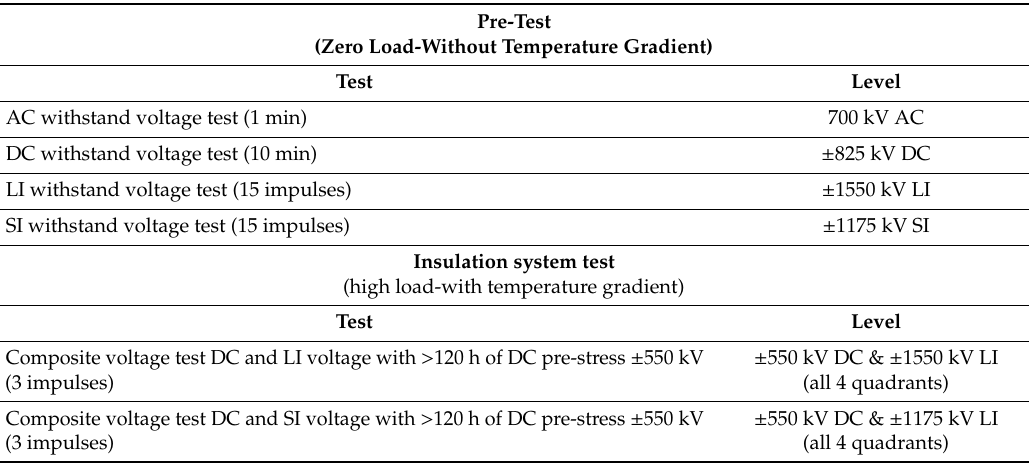
Figure 14. Test setup of an insulation system test [62]. Table 4. Insulation system test procedure for ±550 kV DC GIS [62].